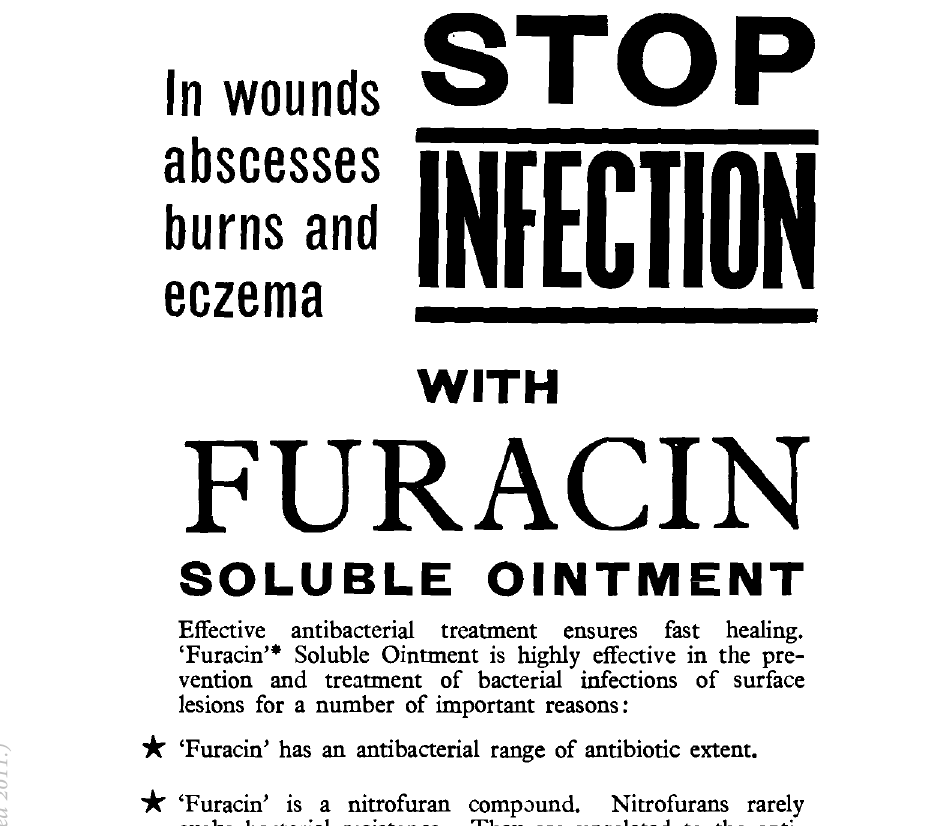
Nitrofurans rarely evoke bacterial resistance. They are unrelated to the anti biotics and sulphonamides and there is no risk of